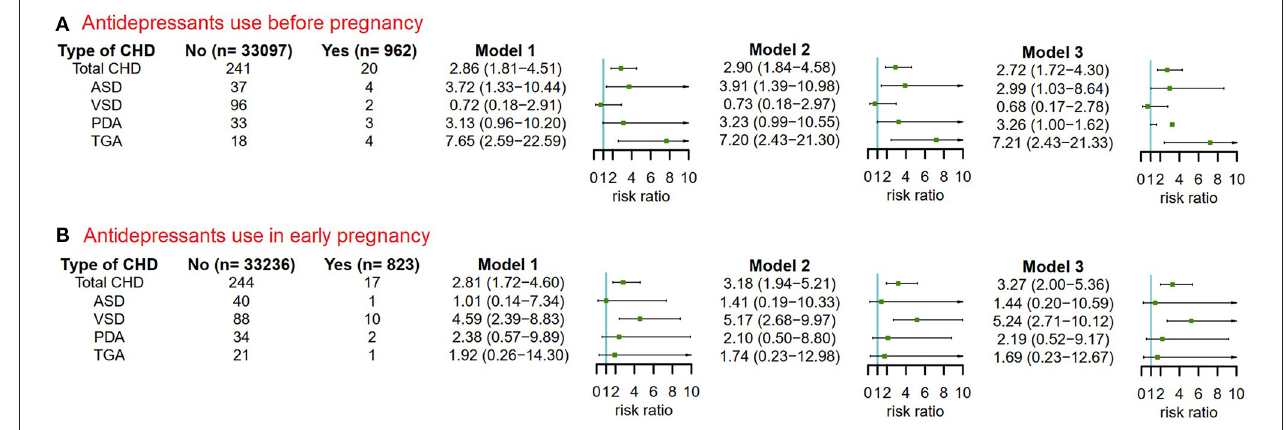
FIGURE 6 | The risks of CHD in offspring of pregnant women exposured to antidepressant in 3 months before pregnancy and in early pregnancy after excluding pregnant women whose children were diagnosed with more than one CHD phenotypes. Model 1 was a crude model without any variable adjusted. Model 2 adjusted for maternal age, ethnicity, residence location, education level, history of gestational diabetes mellitus, history of gestational hypertension, smoking before pregnancy, alcohol drinking before pregnancy and antidepressants use before pregnancy. Model 3 adjusted for maternal age, ethnicity, residence location, education level, history of gestational diabetes mellitus, history of gestational hypertension, smoking before pregnancy, alcohol drinking before pregnancy, antidepressants use before pregnancy, smoking in early pregnancy and alcohol drinking in early pregnancy. CHD, congenital heart disease. (A) Antidepressants use before pregnancy. (B) Antidepressants use in early